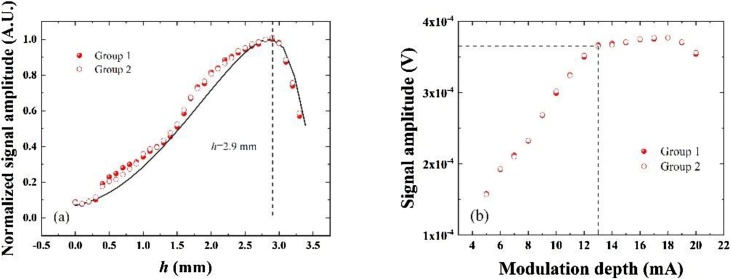
(a) Optimization of the laser focus position. The red dots, red circles and black solid lines represent the experimental group 1, experimental group 2 and numerical results, respectively. (b) Optimization of the laser modulation depth in the QEPAS based on a 28 kHz custom QTF. The red dots and circles represent experimental group 1 and experimental group 2, respectively.